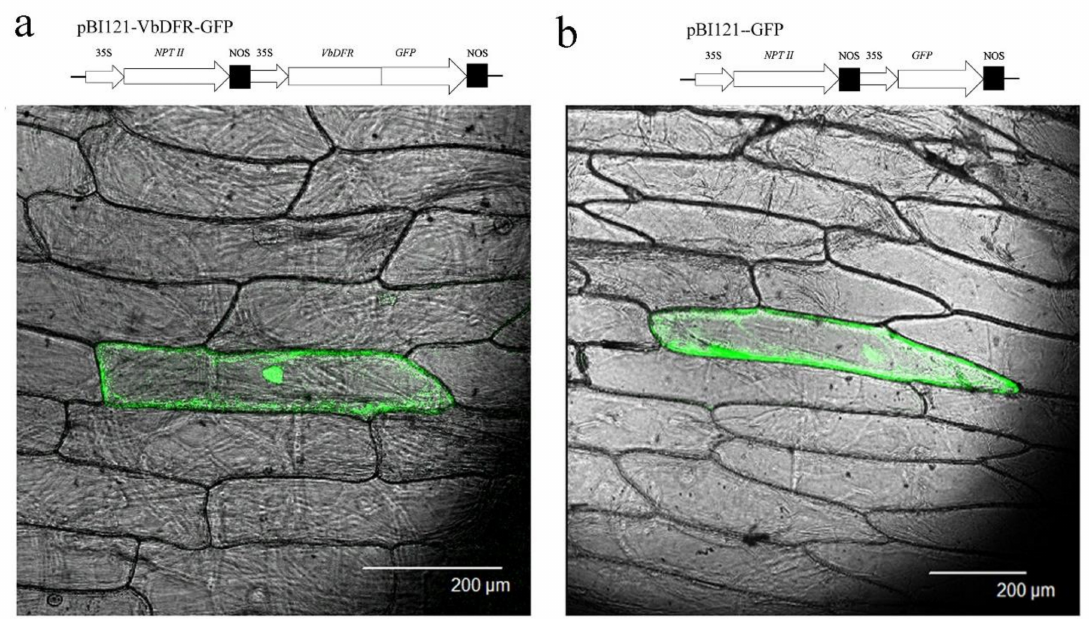
Figure 4. Transient expression using VbDFR-GFP fusion and confocal microscope images. ( a ) a cassette showing VbDFR and GFP fusion and a confocal microscopy image showing subcellular localization of VbDFR-GFP; ( b ) a cassette showing GFP as positive control and a confocal microscopy image showing subcellular localization of